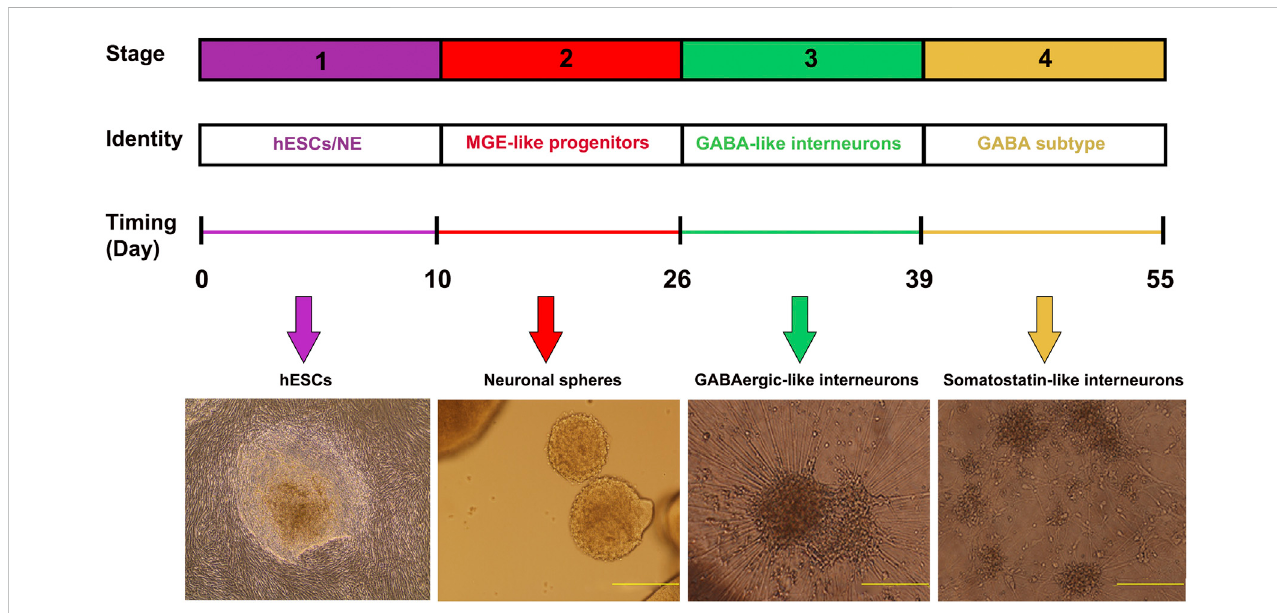
FIGURE 1 Timeline of inhibitory GABA interneuron generation. Cells are differentiated under a chemically de fi ned system. Differentiation of H9-hESC involves 55 days of cultureand four stages,including inductionofneuroepithelial cells, patterningof MGEprogenitors, differentiation to GABAergic-like interneurons, and eventually enriched somatostatin marked interneurons. The morphology of the cells is demonstrated in the images (Yellow bars- 500